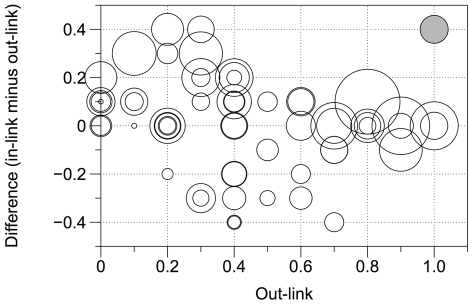
Effects of out-link strength and in- minus out-link on cooperative investment.Point size reflects standardised time squatted: white points show actual data, grey point is for reference only and corresponds to a standardised time of 1 Participants suffered a higher cost for recipients to whom they had declared a strong social link (p<0.001) and who had declared a a stronger social link to them (in-link minus out-link, p = 0.001).